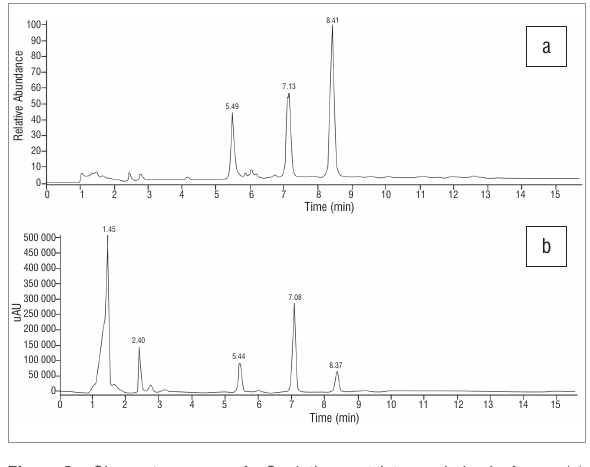
Figure 9 : Chromatograms of Sceletium strictum derived from (a) electrospray ionisation mass spectroscopy and (b) high- performance liquid chromatography with